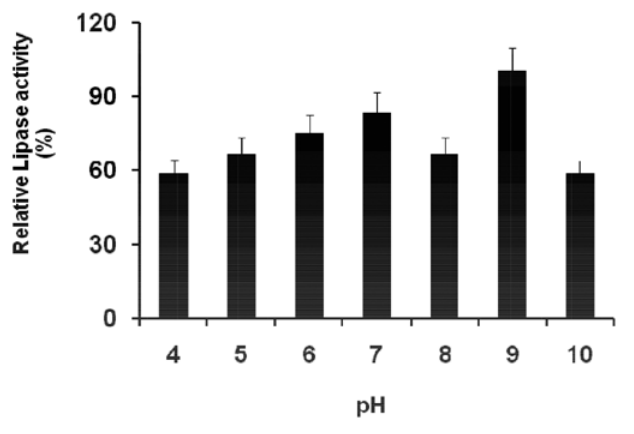
Fig. 2 - Effect of different pH values on the activity of F. culmorum SY6 lipase.